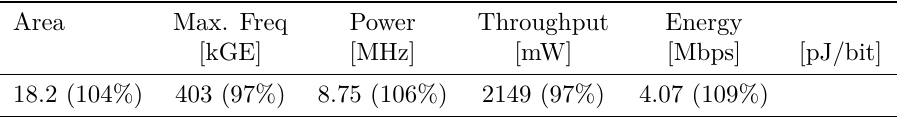
Table 19: Spook v2 ASIC implementation results (post place-and-route) with N u = 8. The percentages are the comparison with the Spook v1 corresponding metrics.